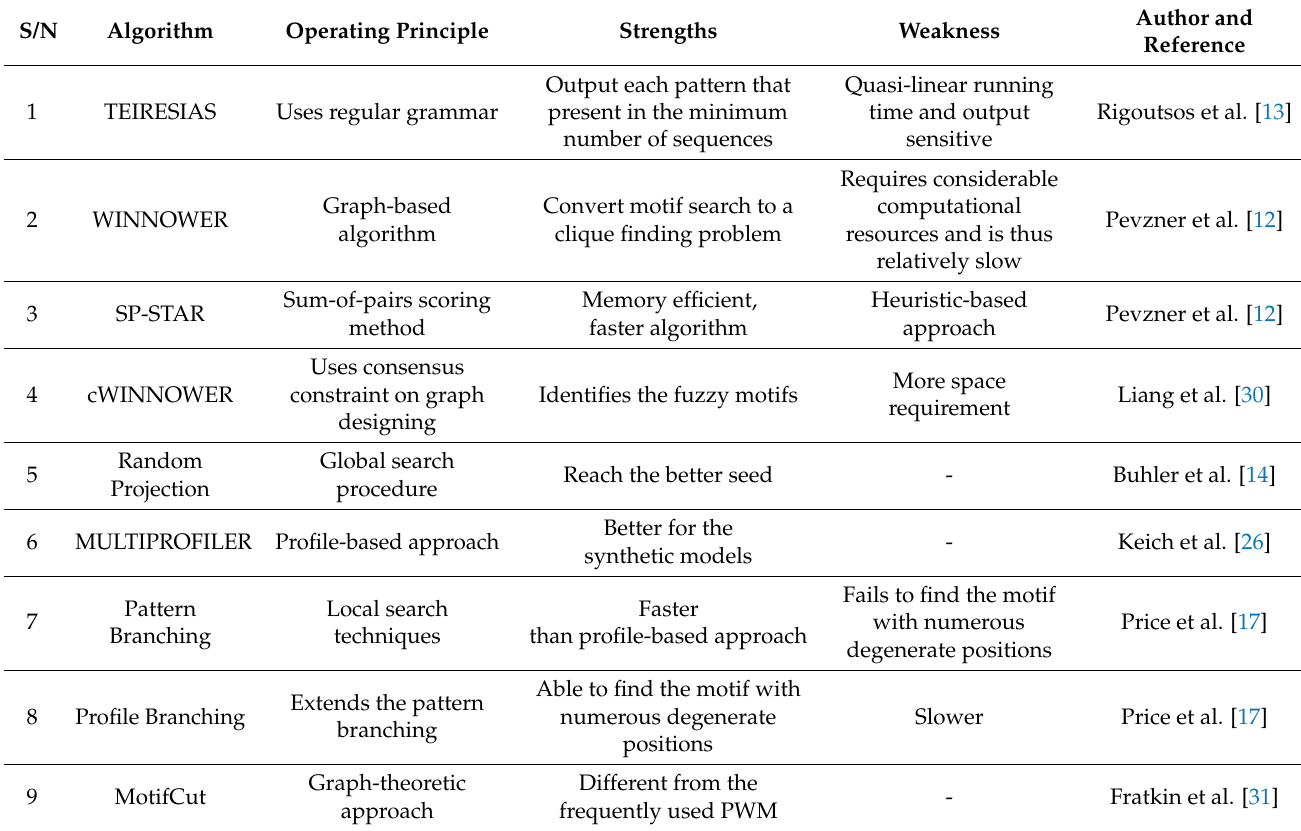
Table A2. List of Motif Discovery Algorithms based on Local Search Approach.